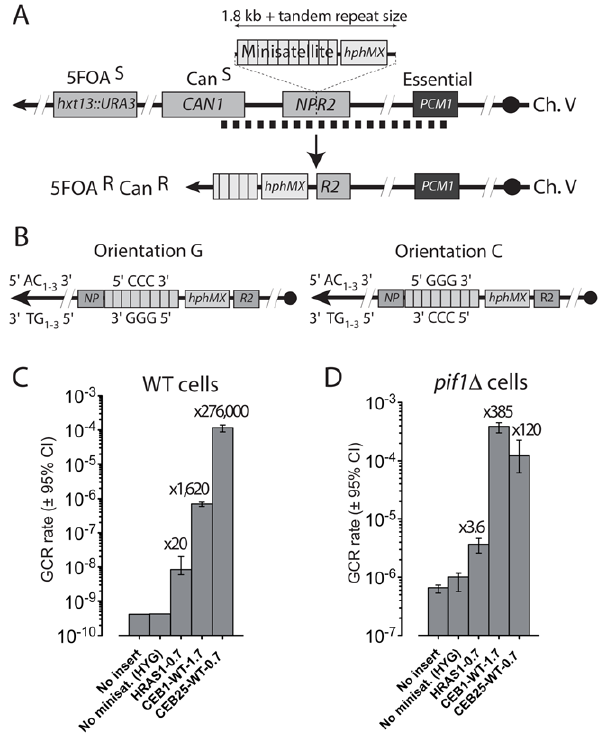
Figure 1. GC–rich minisatellites induce the formation of GCR in WT and pif1 D cells. (A) Schematic representation of the GCR assay on the S. cerevisiae chromosome V. URA3 has been inserted at the HXT13 locus ( hxt13::URA3 ) [28]. The CAN1 and URA3 genes confer sensitivity to canavanine (Can) and 5-fluoroorotic acid (5FOA), respectively. Plating cells on media containing both Can and 5FOA allows detecting the simultaneous loss of both markers, occurring upon genomic rearrange- ments (GCR) in the non-essential region between the first essential gene PCM1 and CAN1 ( < 13 kb, dotted line) [28]. The rate of GCR is determined by fluctuation analysis of 5FOA/Can-resistant colonies occurrence (see Materials and Methods). A cassette containing the hphMX gene and the minisatellite of interest is inserted in the closest centromere-proximal position to the CAN1 and URA3 genes, at the NPR2 locus. The example of a telomere addition in the tandem repeat associated with the loss of the distal part of the chromosome V is shown. (B) Schematic representation of the two orientations in which CEB1 has been inserted relatively to the distal telomere. (C) GCR rates in WT strains bearing no insert (RDKY3615), no minisatellite